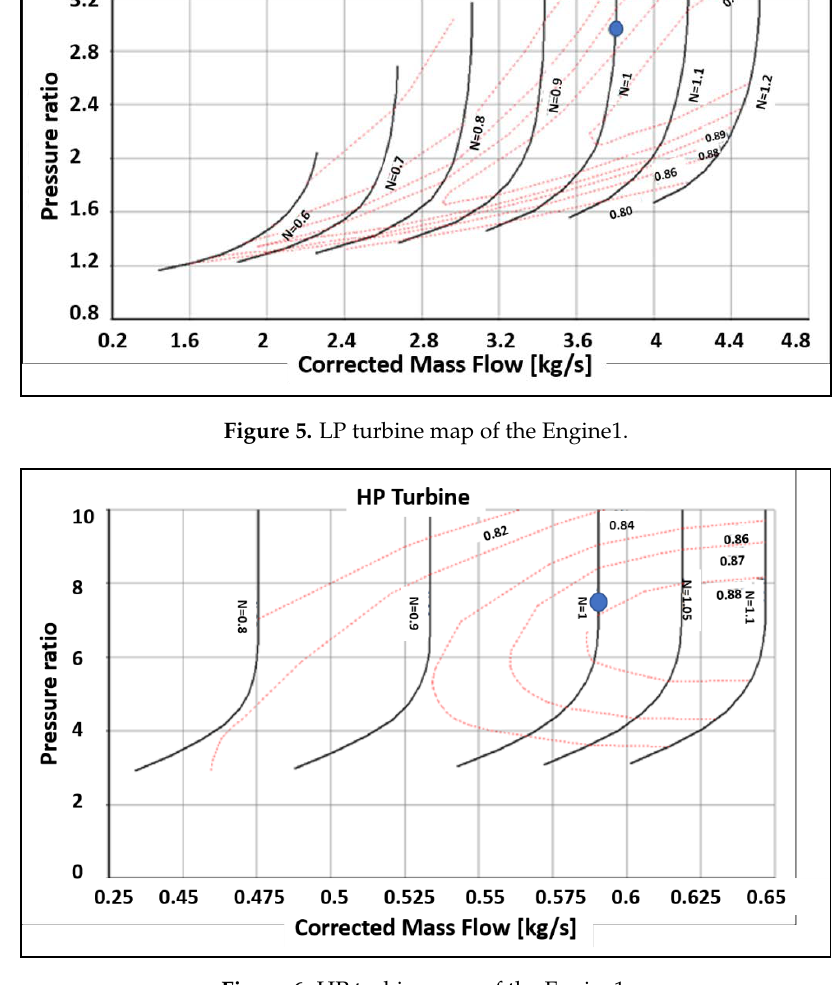
Figure 6. HP turbine map of the Engine1.